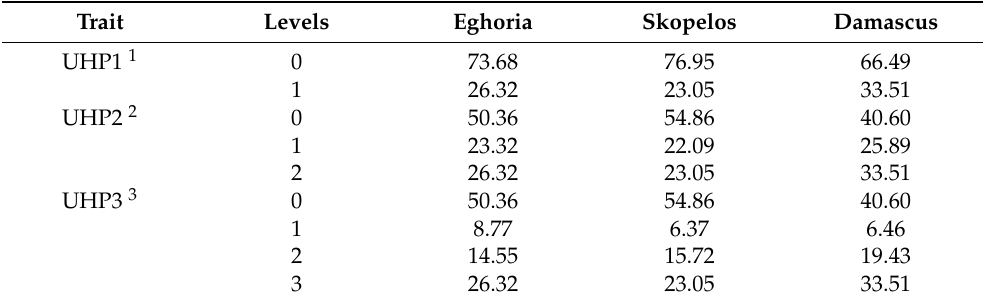
Table 2. Frequency (%) of udder health phenotypes derived from milk somatic cell count and total viable count in the studied goat breeds.